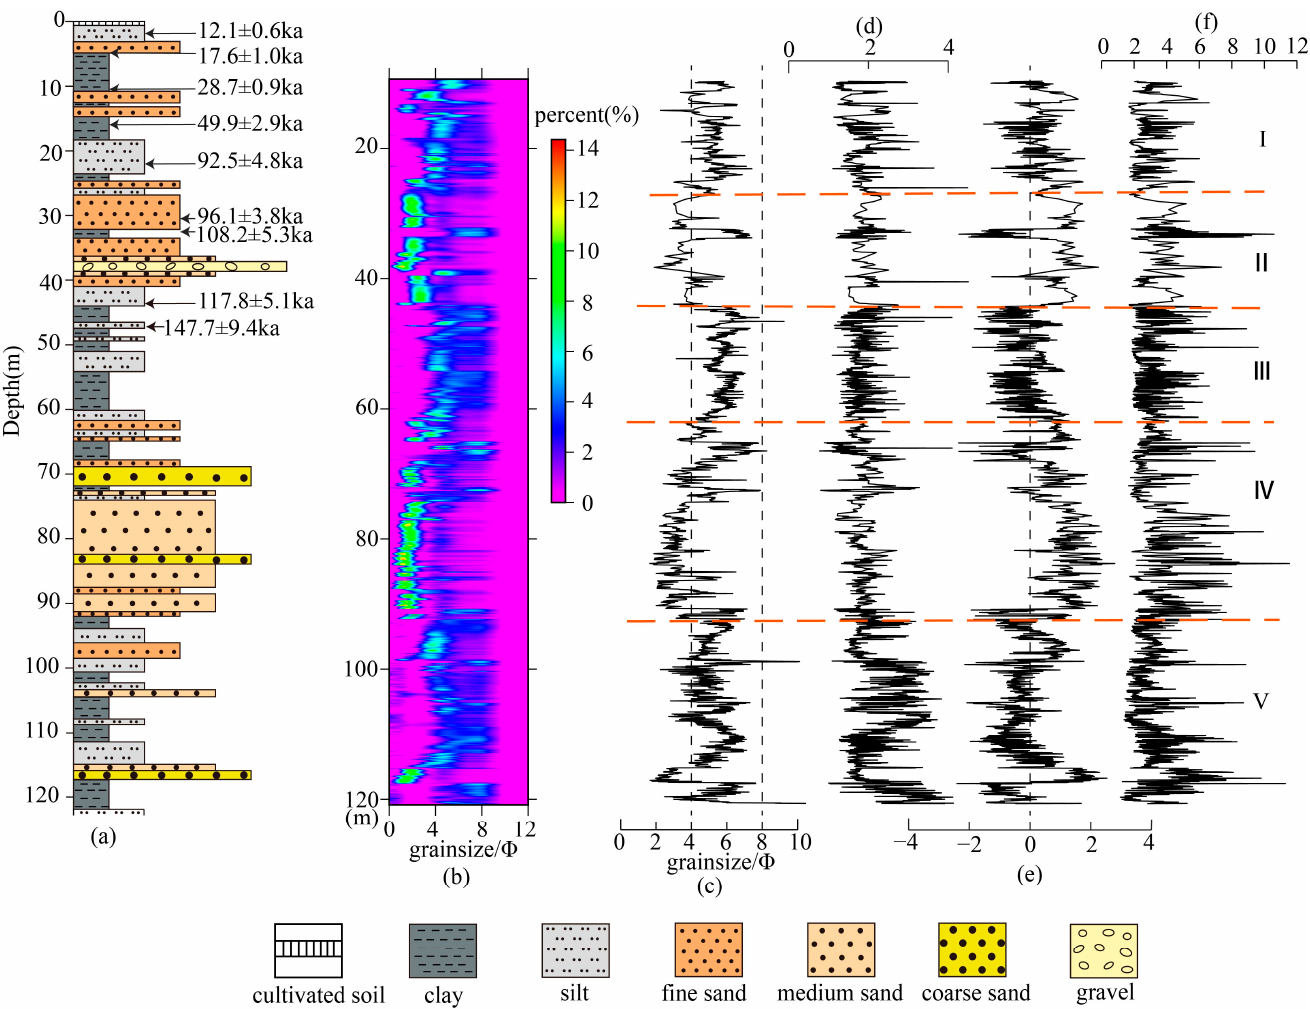
Figure 2. Stratigraphic histogram, grain size contour map, and grain size parameters of the SHBZK − 1. ( a ) Stratigraphic histogram; ( b ) grain size contour map; ( c ) mean size (Mz); ( d ) standard deviation ( 𝛔 ); ( e ) skewness (Sk); ( f ) kurtosis (K G ).